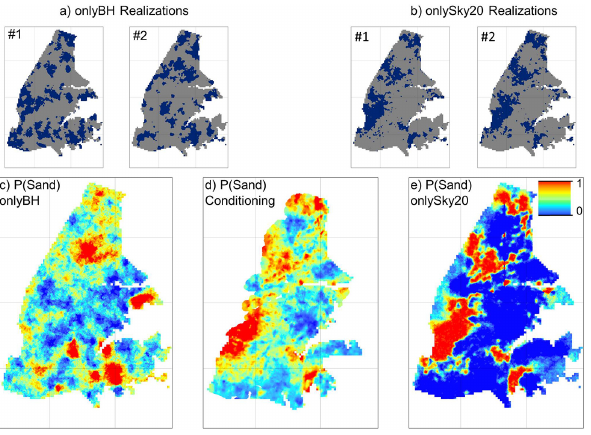
Figure 4. Upper panel: two individual realizations for two different conditioning scenarios: onlyBH (a) and onlySky20 data (b) . Lower panel: probability maps for the two scenarios (c) and (e) showing the probability of sand in each cell based on 25 realizations. The derived sand probability which is used for conditioning the simula- tion is shown in (d) . All maps show data at an elevation of